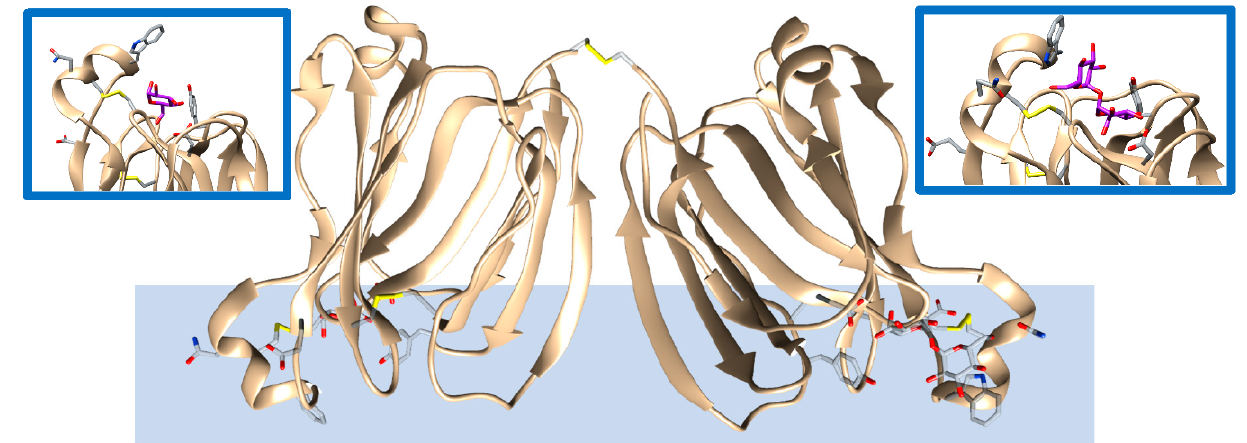
Figure 3. Lectin protein (PPL3A, brown, PDB entry 5yrf [50]) found in pearls and binding calcite biominerals. Amino acids and trehalose, in addition to the carbohydrate mediating the interactions with the biomineral, are highlithed as a stick representation. The biomineral is represented as a light blue color shape and is for rendition purposes only. Several intra- and one interchain -S-S bonds are present that could facilitate protein orientation for binding to the mineral surface. The insets provide zoom views of the bound carbohydrates (purple color) interacting with the represented side chains as found in the experimental structure.